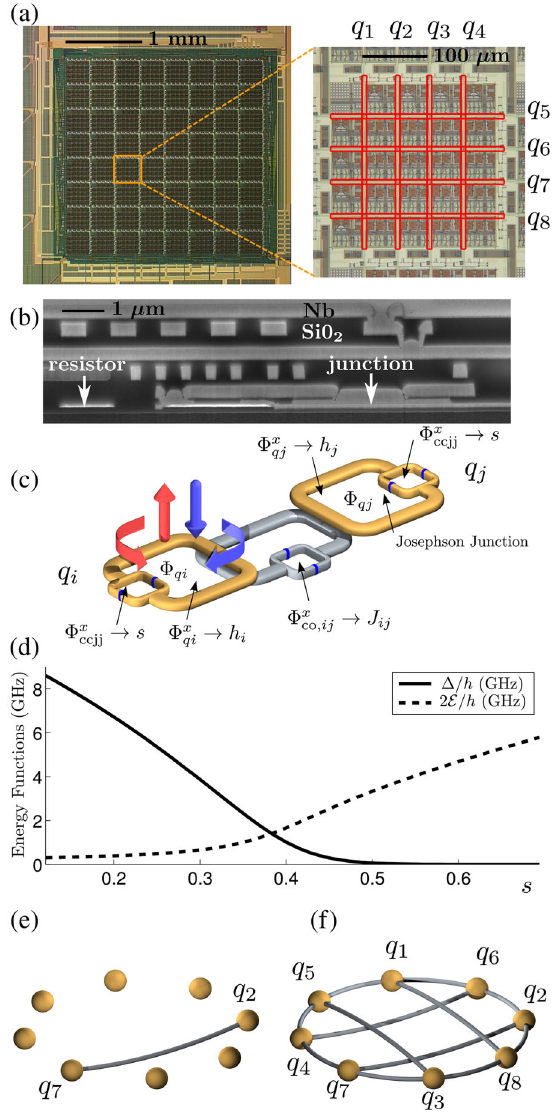
FIG. 1. (a) Photograph of the QA processor used in this study. We report measurements performed on the eight-qubit unit cell indicated. The bodies of the qubits are extended loops of Nb wiring (highlighted with red rectangles). Inter- qubit couplers are located at the intersections of the qubit bodies. (b) Electron micrograph showing the cross section of a typical portion of the processor circuitry (described in more detail in Appendix A). (c) Schematic diagram of a pair of coupled superconducting flux qubits with external control and Φ x and with flux through the body of the i th biases Φ x qi ccjj . An inductive coupling between the qubit denoted as Φ qi qubits is tuned with the bias Φ x . (d) Energy scales Δ ð s Þ co ;ij and E ð s Þ in Hamiltonian (1) calculated from a rf SQUID model based on the median of independently measured device parameters for these eight qubits. See Appendix A for more details. (e),(f) The two- and eight-qubit systems studied were programmed to have the topologies shown. Qubits are represented as gold spheres, and interqubit couplers, set to J ¼ − 2 . 5 , are represented as silver